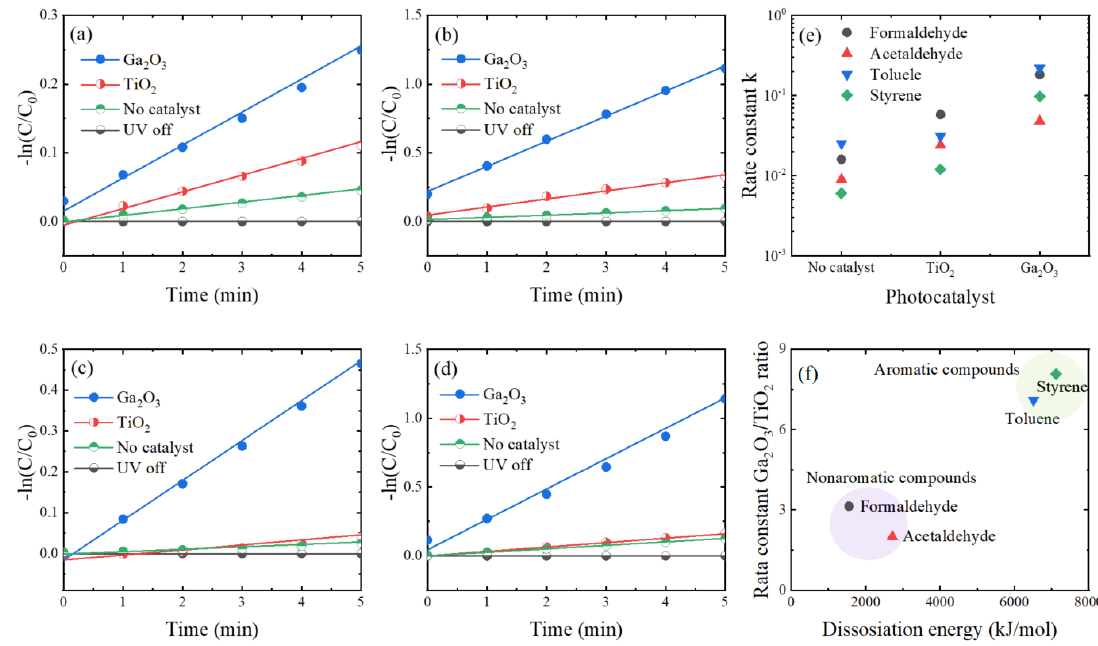
Figure 2. ( a – d ) Photocatalytic degradation kinetics with a linear fit for ( a ) formaldehyde, ( b ) acetaldehyde, ( c ) toluene, and ( d ) styrene, respectively, using Ga 2 O 3 , TiO 2 , and no catalyst under UVC irradiation and without UV irradiation at room temperature. ( e ) Comparison of the rate constants of volatile organic compound (VOC) photodegradation with Ga 2 O 3 , TiO 2 , and no catalyst. ( f ) Rate constant ratio of Ga 2 O 3 over TiO 2 as a function of dissociation energy of different VOCs.